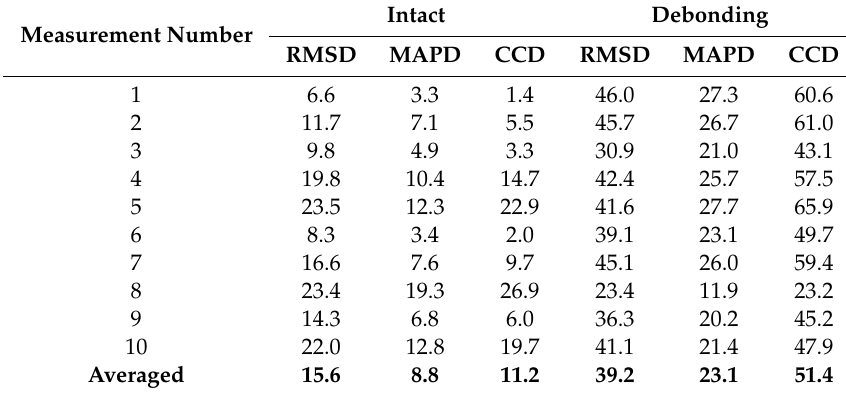
Table 2. Results for 0.4 mm thickness top composite plate.